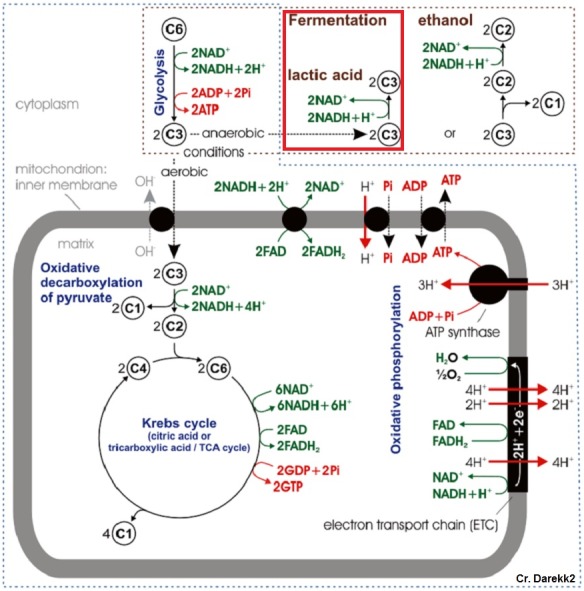
Typical cellular respiration pathway in eukaryotic cells.Red box denotes anaerobic respiratory pathway of interest.